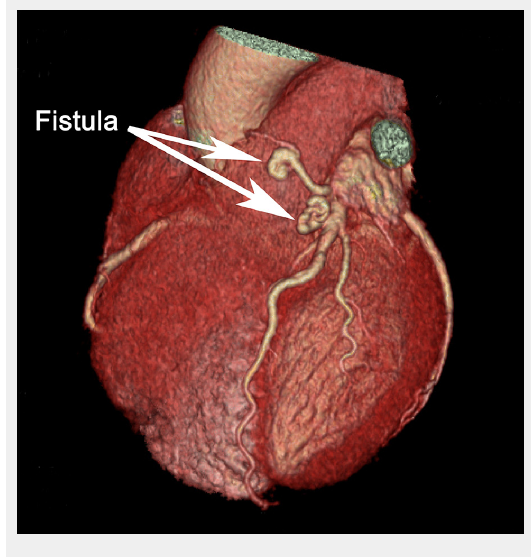
CCTA of a 64-year-old patient with atypical angina referred for exclusion of CAD shows no relevant CAD but a coronary artery fistula originating from the LAD and terminating in the pulmonary artery, potentially causing his symptoms.